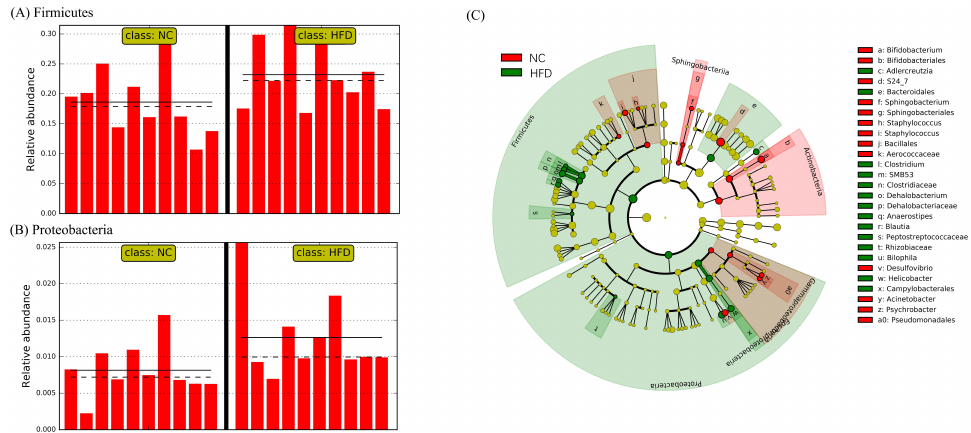
Figure 5. Select microbial taxa displaying significantly di ff erent abundance between NC and HFD groups. The two phyla significantly impacted by HFD are depicted in ( A ) Firmicutes and ( B ) Proteobacteria. x -axis: individual samples. y -axis: relative abundance percentage. Straight line: group mean abundance. Dotted line: median. Taxa meeting a significant LDA threshold value > 2.0 and its corresponding taxonomic cladogram are depicted in ( C ). NC: normal control diet; HFD: high-fat and high-sucrose